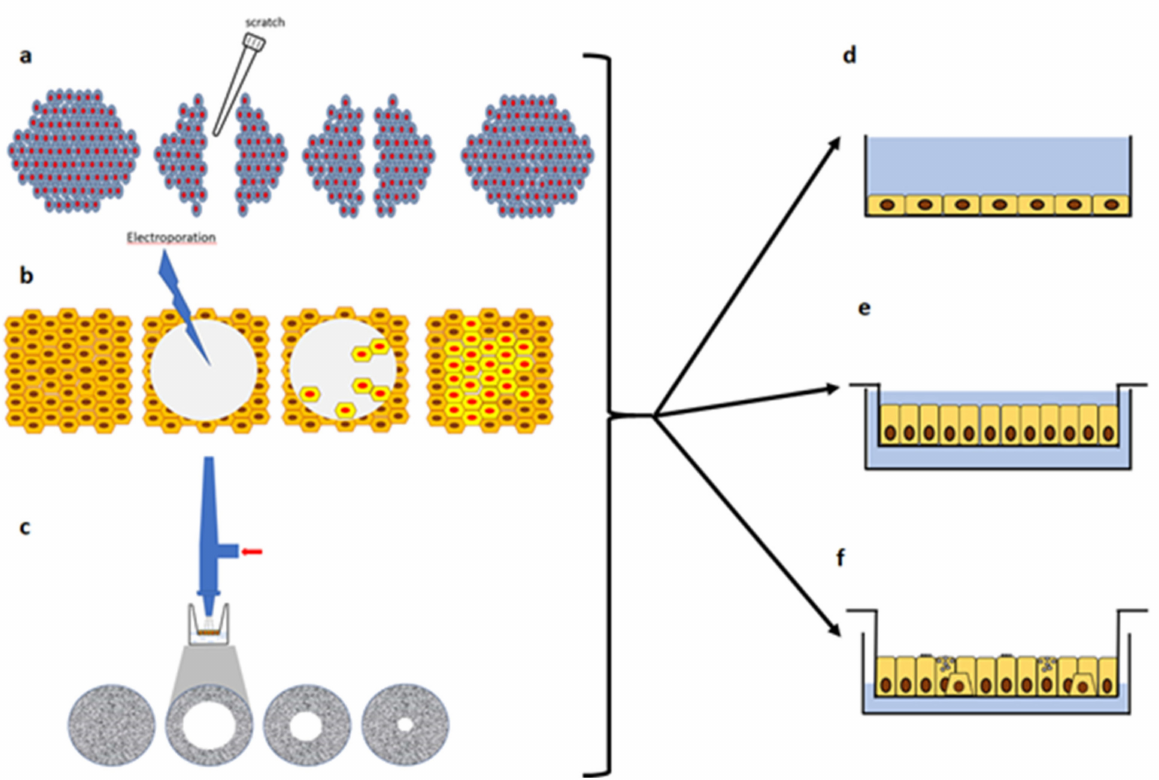
Figure 4. Methods of wound injury in different models of airway epithelial cell cultures. ( a ) Mechanical injury by the pipette tip (scratch assay). ( b ) Circular lesion produced by lethal electroporation. ( c ) Circular wounds obtained by an airbrush linked to a pressure regulator. ( d ) Submerged cultures of immortalized cell lines on plastic. ( e ) Polarized cultures of immortalized and primary cells seeded onto semipermeable filters. ( f ) ALI cultures on semipermeable filters. While immortalized cell lines polarize but not differentiate at ALI (e.g., Calu-3), primary airway epithelial cells differentiate at ALI into a pseudostratified epithelium presenting ciliated, basal, secretory, and mucus-producing goblet